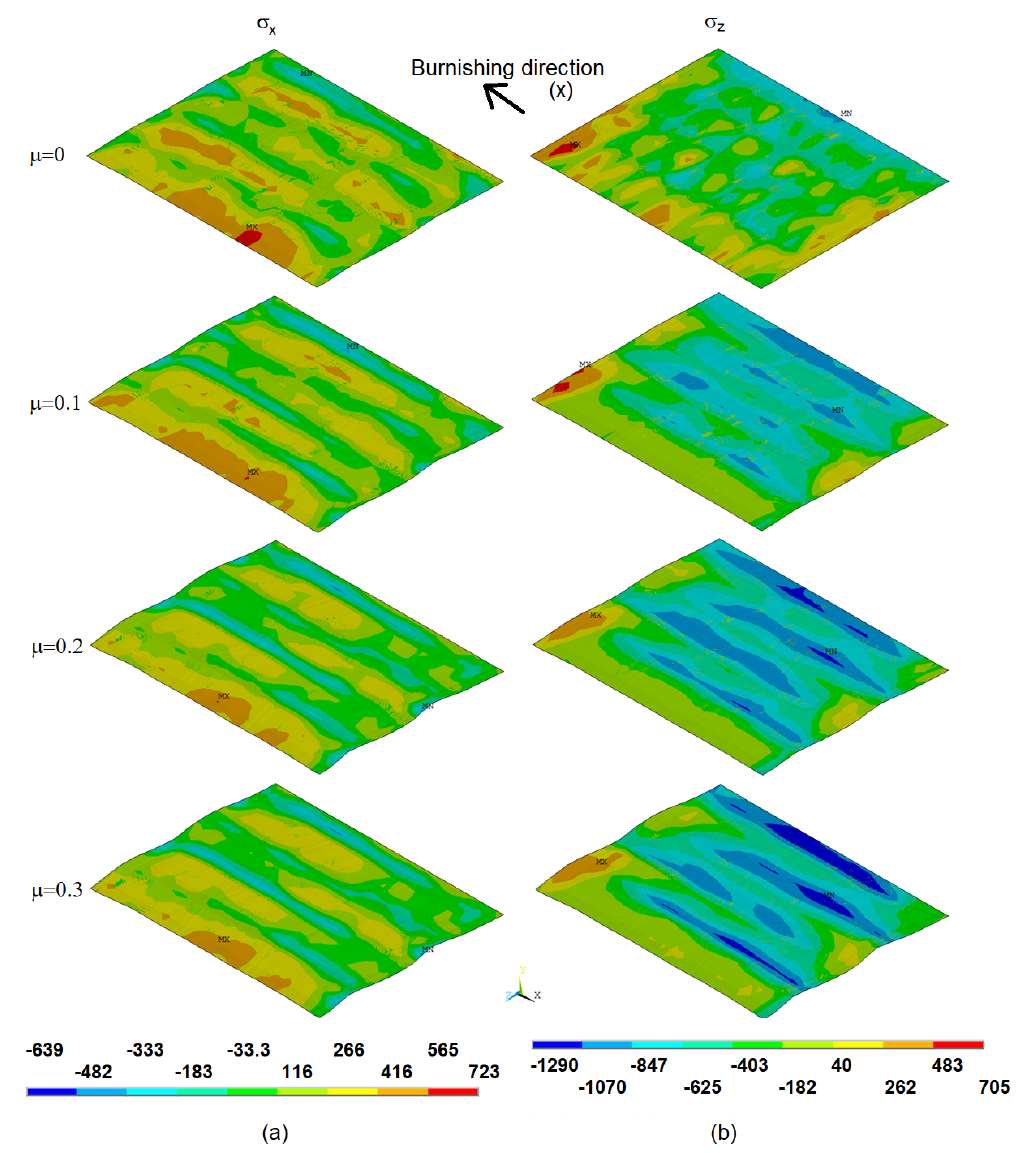
Figure 4. Evolution of residual stress (MPa) as the coefficient of friction increases. ( a ). Along the burnishing direction. ( b ). Perpendicular to the burnishing